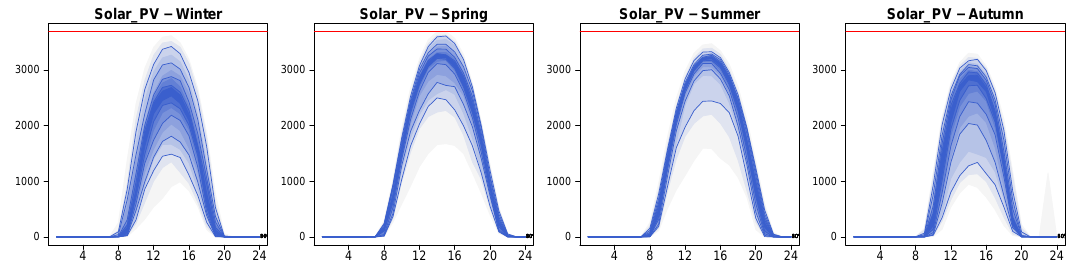
Figure 2. The Solar Photovoltaic seasonal pattern for 2017. Source: authors based on the data from REE [11].